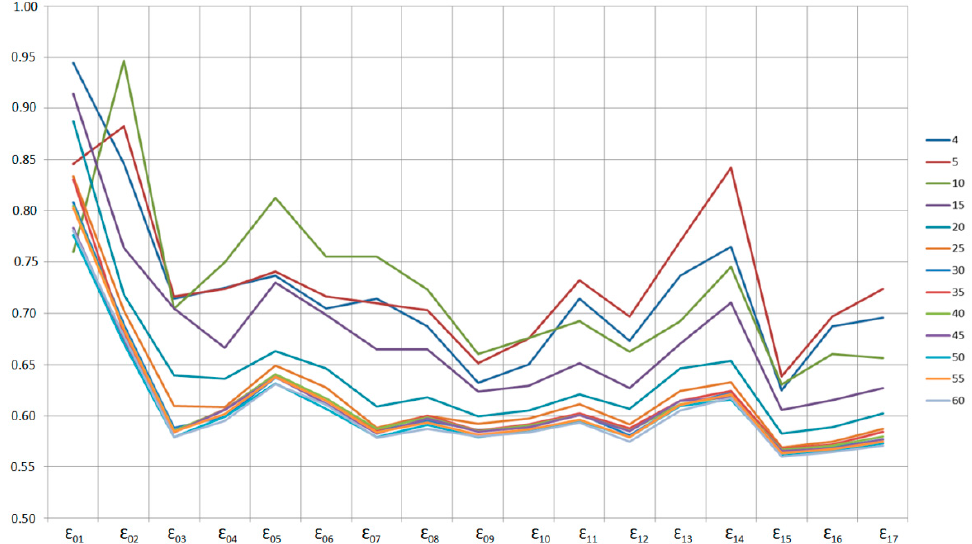
Figure 2. Diagram of the values of the similarity coefficient ε representing the strength of the analyzed relationships in terms of the number of observations included in the model. The lines representing the values of Ɛ in models with 4, 5, 10 and 15 observations (four top trend lines in Figure 2) diverge from the lines plotted for models with 25 to 60 observations (bottom lines in Figure 2). The shape of the line denoting the model with 20 observations is similar to the line representing models with 25 to 60 observations. These